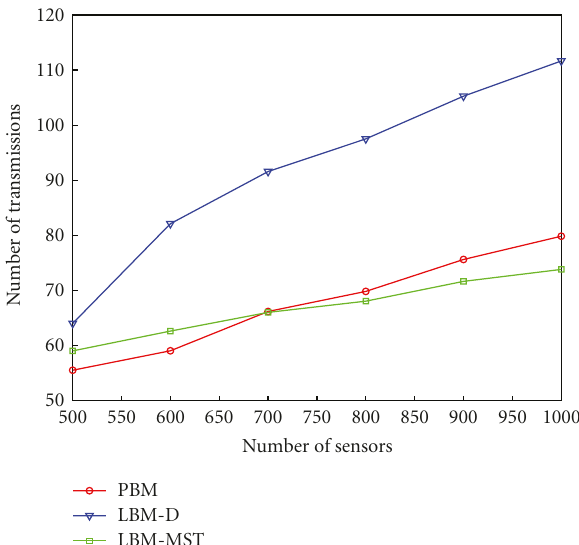
Figure 14: Number of transmissions for separately distributed